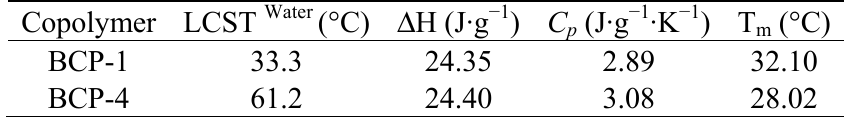
Table 2. Thermodynamic properties of copolymers measured using